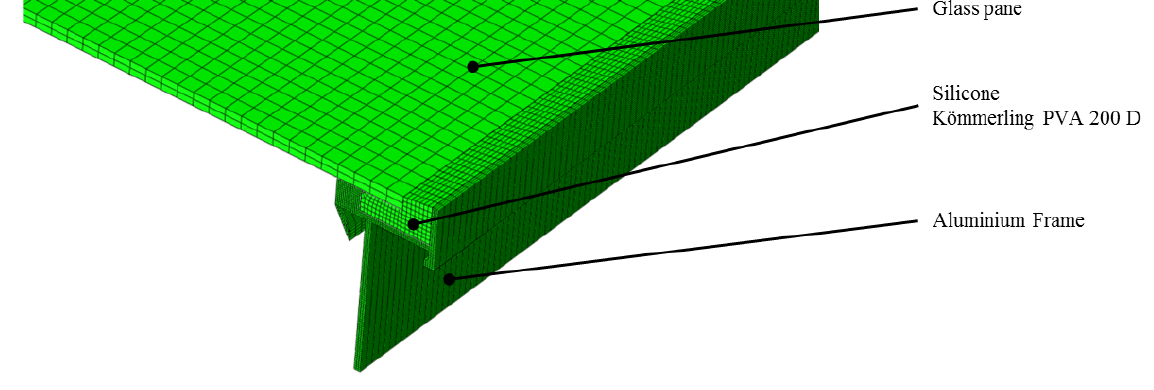
Fig. 5 Detail of the global model with indication of the different parts